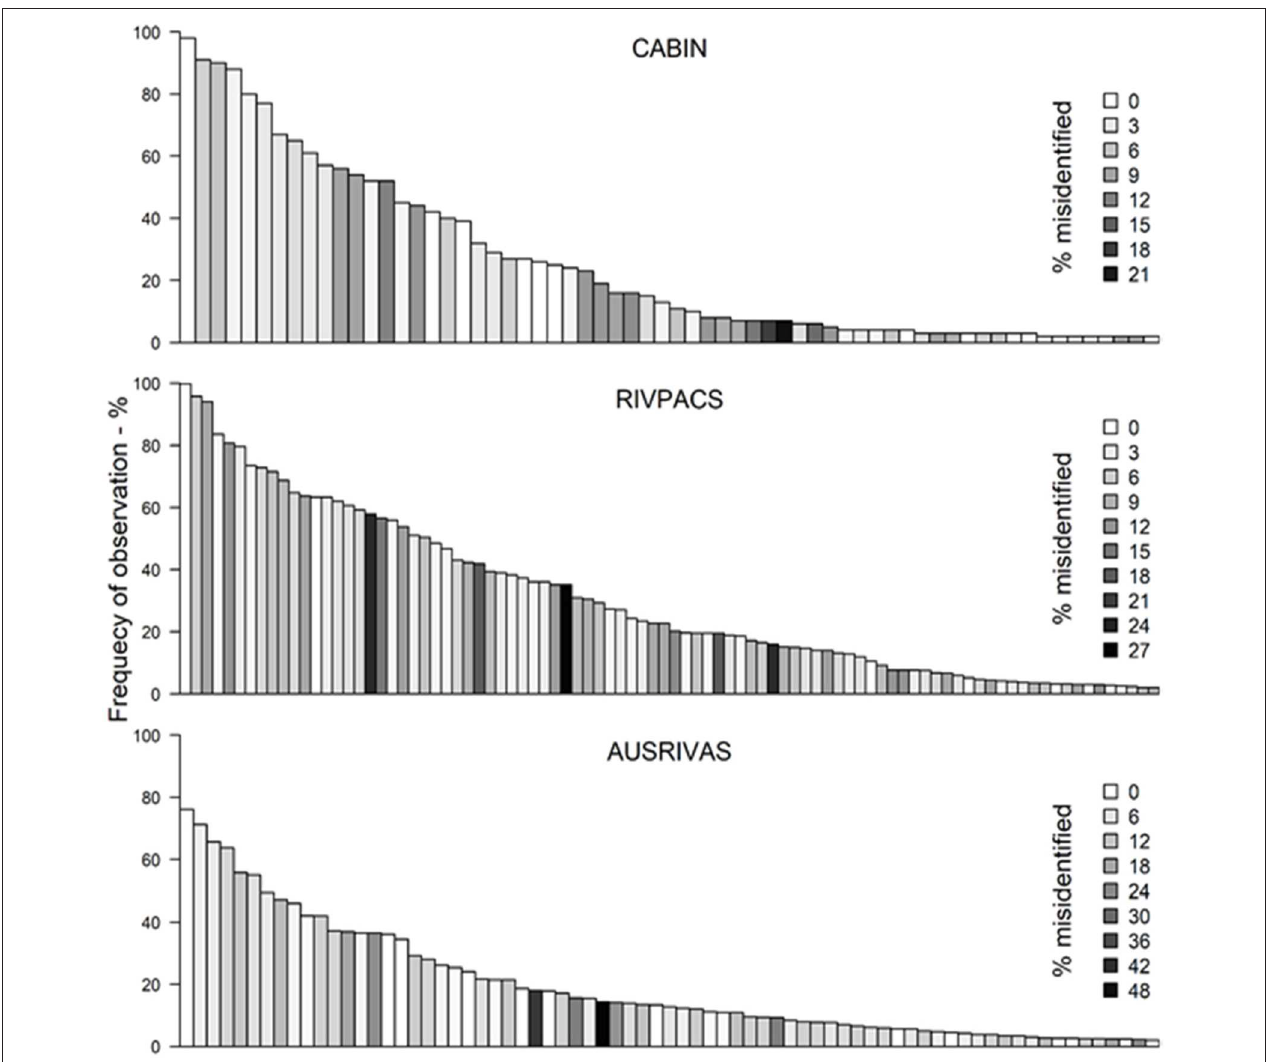
FIGURE 3 | Families ordered by frequency of occurrence within three biomonitoring programs: the CABIN ( n = 540), the UK River Invertebrate Prediction and Classification System (RIVPACS, n = 2,504), and the Australian River Assessment System (AUSRIVAS n = 1,516) from Victoria. Shading reflects the likelihood taxa could be misidentified using the CO1 RDP classifier v.3 (see Supplementary Material S1 for further